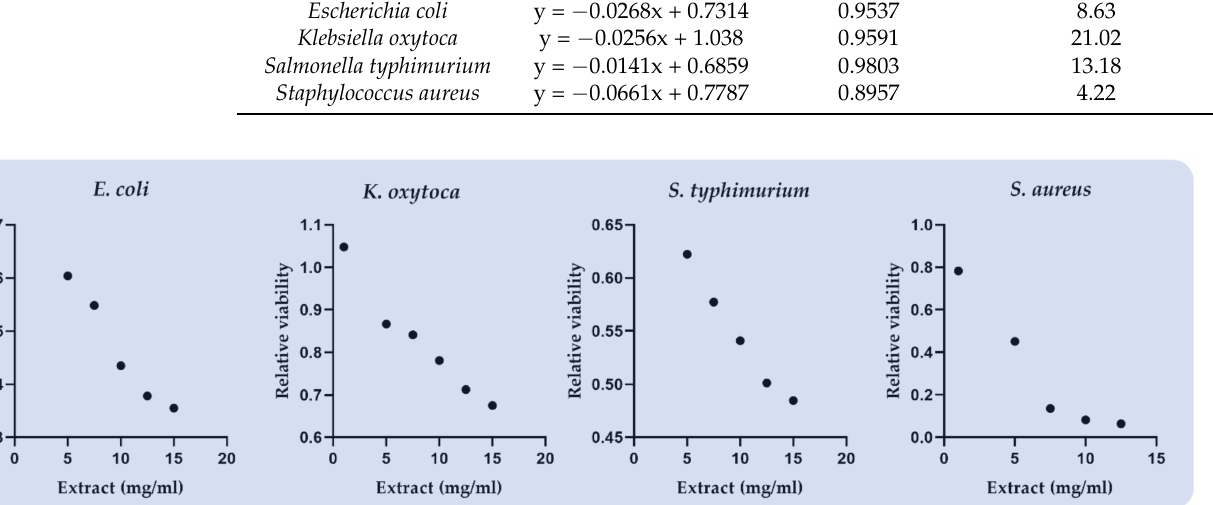
Figure 1. The effect of Citrus reticulata carotenoid extract included in soluble starch in the relative viability of E. coli, K. oxytoca, S. typhimurium, and S. aureus using MTT